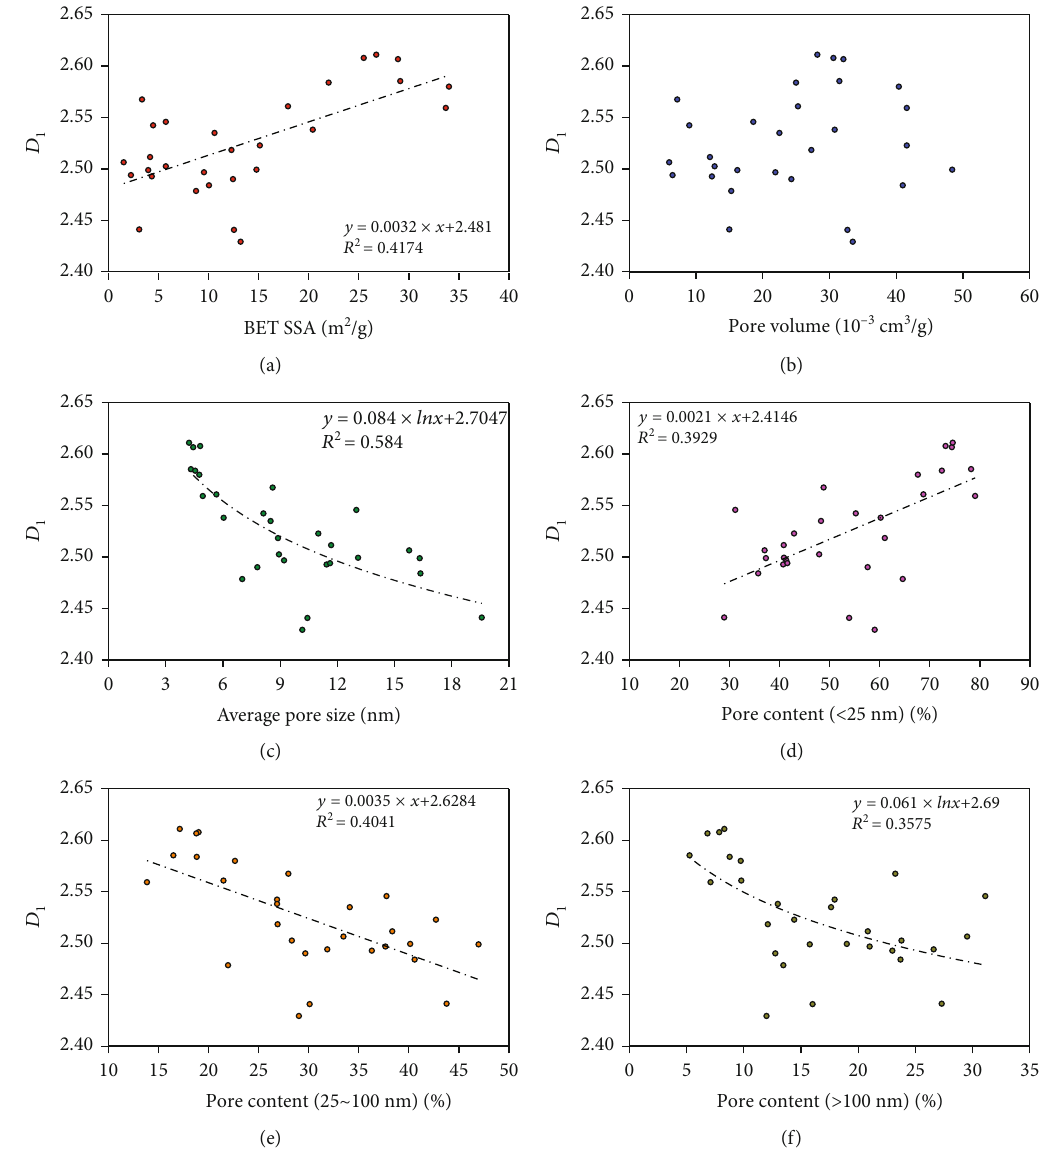
Figure 9: Relationships between D